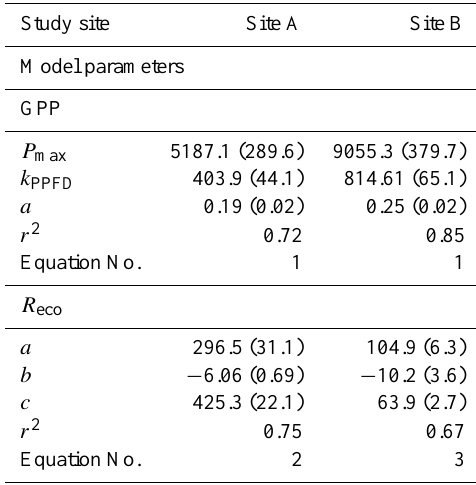
Table 3. Estimated parameter values for gross photosynthesis (GPP) and ecosystem respiration ( R eco ) models (see related equa- tions in the text). Standard error of the model parameter in parenthe- ses. Coefficient of determination ( r 2 ) values and equation number are shown. p -values for all parameters